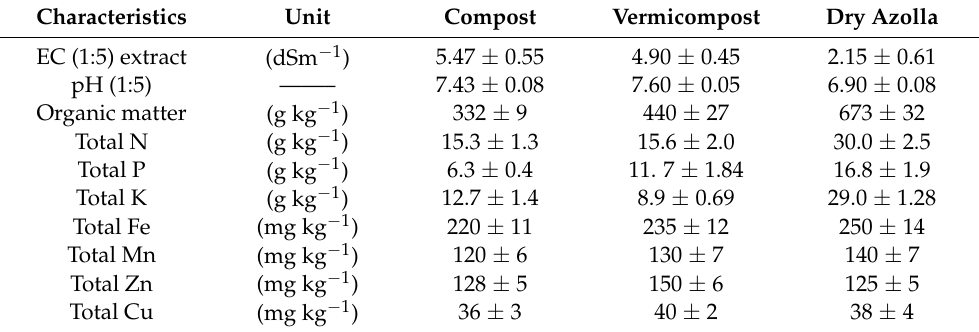
Table 2. Chemical composition of organic amendments used in this study.